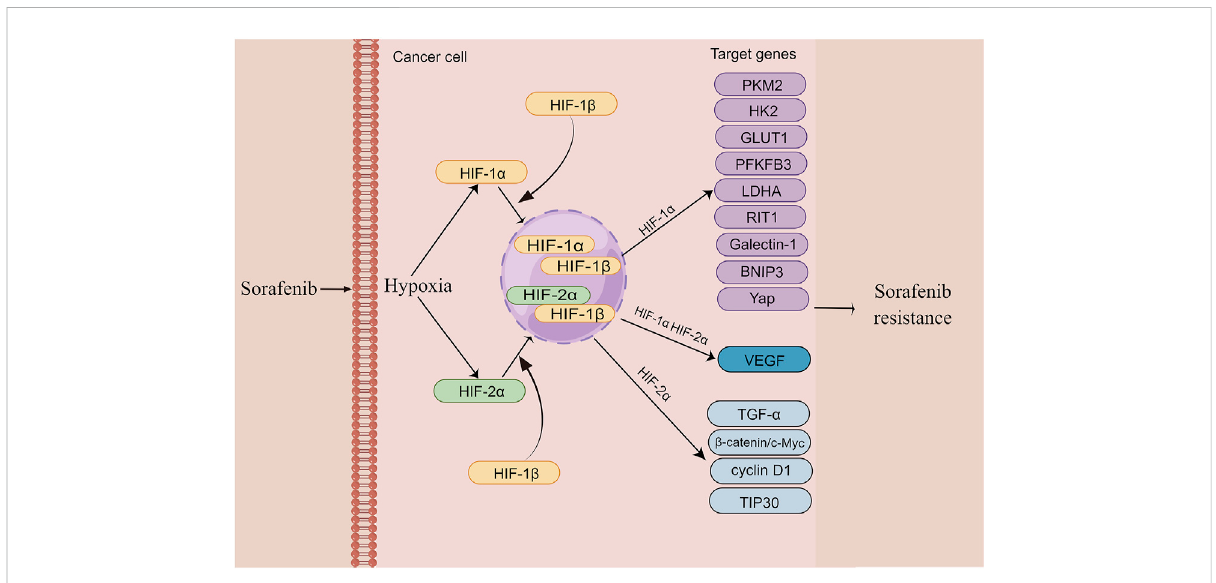
FIGURE 3 The mechanism of hypoxia induces sorafenib resistance in HCC (edited by Figdraw software). Sustained sorafenib treatment induces dysregulation of HIF-1a and HIF-2a expression and promotes transcription of their downstream genes, thereby causing resistance to sorafenib in